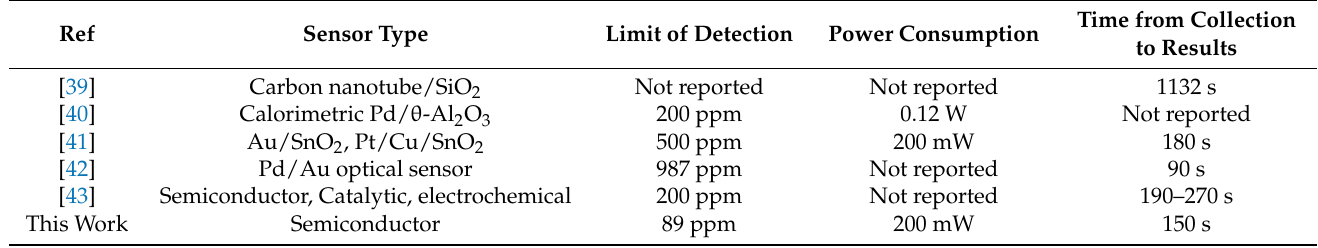
Table 1. Comparison of select hydrogen and natural gas mixture monitoring platforms by key char- acteristics.